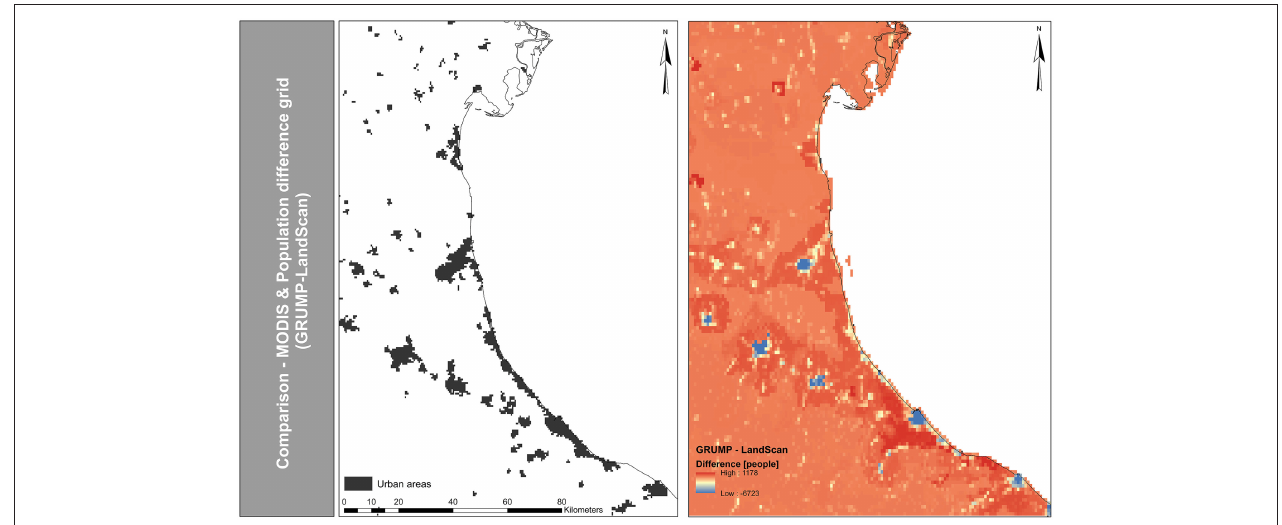
FIGURE 10 | Comparison of the GRUMP-LandScan difference grid to the urban areas of the MODIS land cover